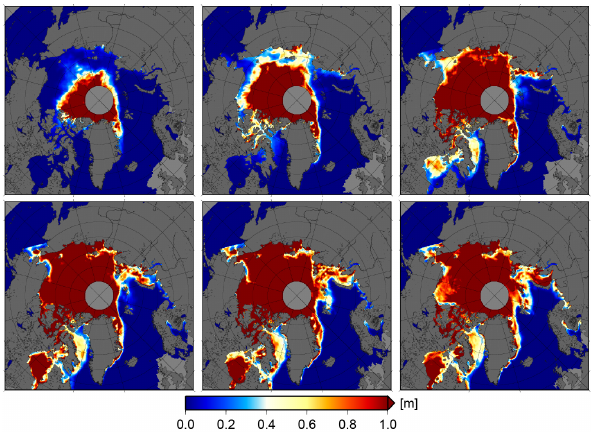
Figure 15. Monthly sea ice thickness derived from Algorithm II* during the freeze-up period of October 2012 to March 2013 (from upper left to lower right) in the Arctic. Months: October 2012 (up- per left), November 2012 (upper middle), December 2012 (upper right), January 2013 (lower left), February 2013 (lower middle), and March 2013 (lower